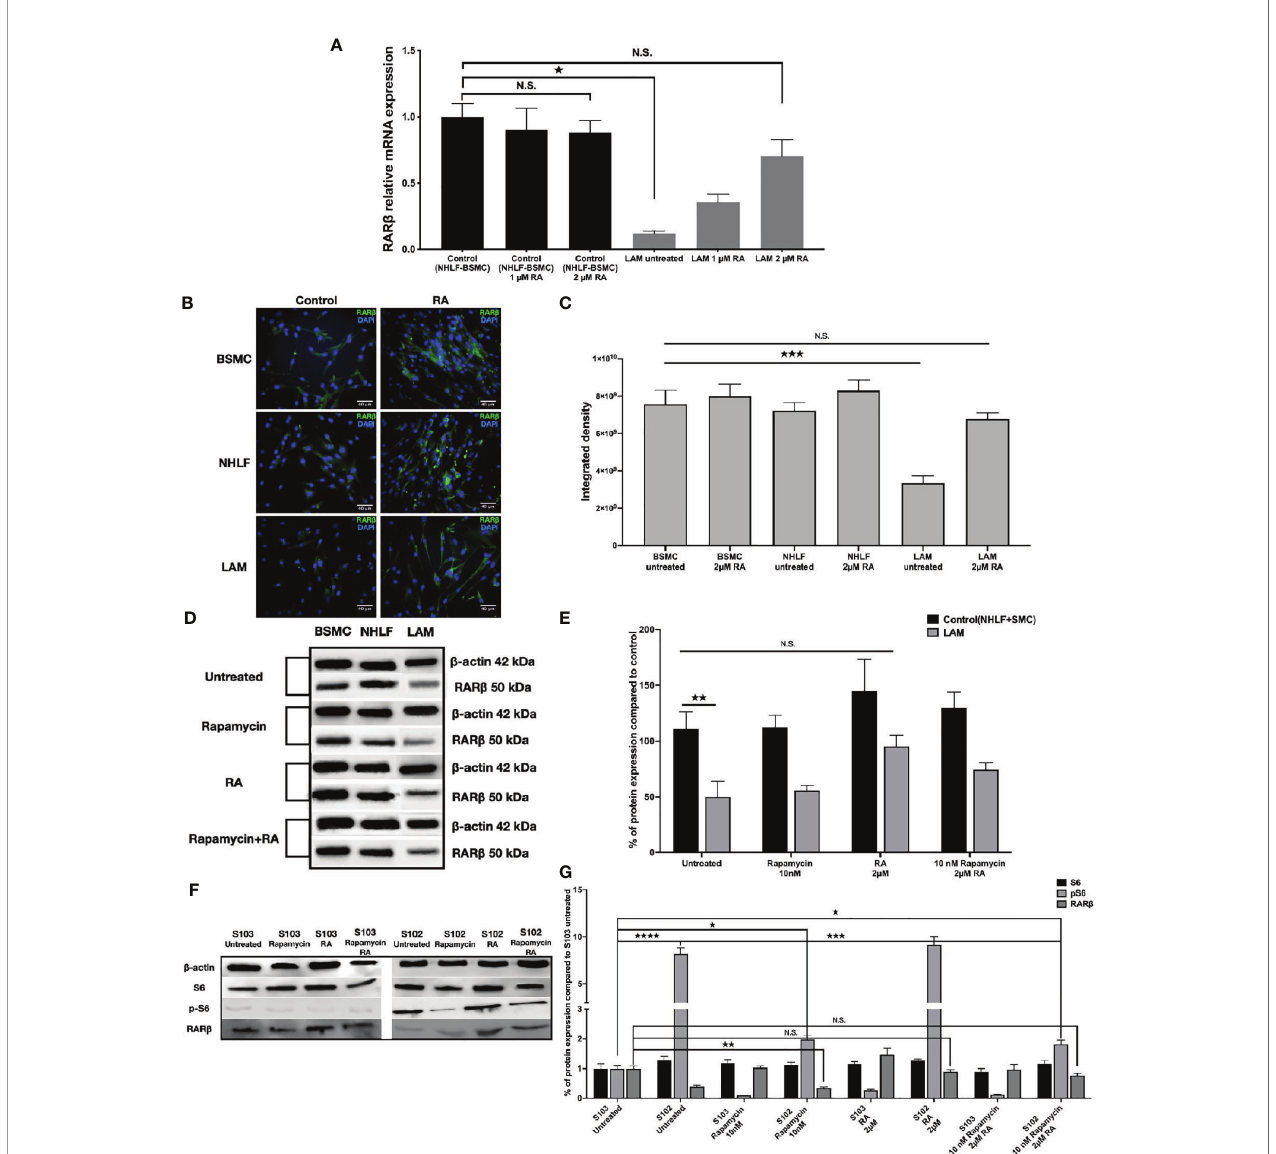
FIGURE 2 | Restoration ofRAR b expression byRA. (A) mRNA expression levels of RAR b are signi fi cantly increased inLAM cell lines (n=4) comparedto controlsBSMC andNHLFafter 2 m M RA treatment for 24 h.Signi fi cant changes are marked as ★ (P<0.05). (B, C), Protein expression levelsofRAR b usingimmuno fl uorescence staining in LAMcelllines compared to controls(BSMCand NHLF)after 2 m M RA treatment for 24 h.Immuno fl uorescence staining RAR b green, DAPI blue, magni fi cation 40x, size-bar 40 m m. (D,E) Western blot analysis of RAR b proteinlevelsin LAMcelllines and control cells (NHLF and BSMC). (F, G) WesternblotanalysisofRAR b , S6 andpS6 protein levelsin S102 cellline compared to S103. WBproteinexpression levelswere quanti fi edby ImageJand are presented as percentage compared to controls. Changes are markedas N.S. (Non Signi fi cant) or signi fi cant ★ , ★★ , ★★★ and ★★★★ (P<0.05, P<0.001, P<0.0002 and P<0.0001,